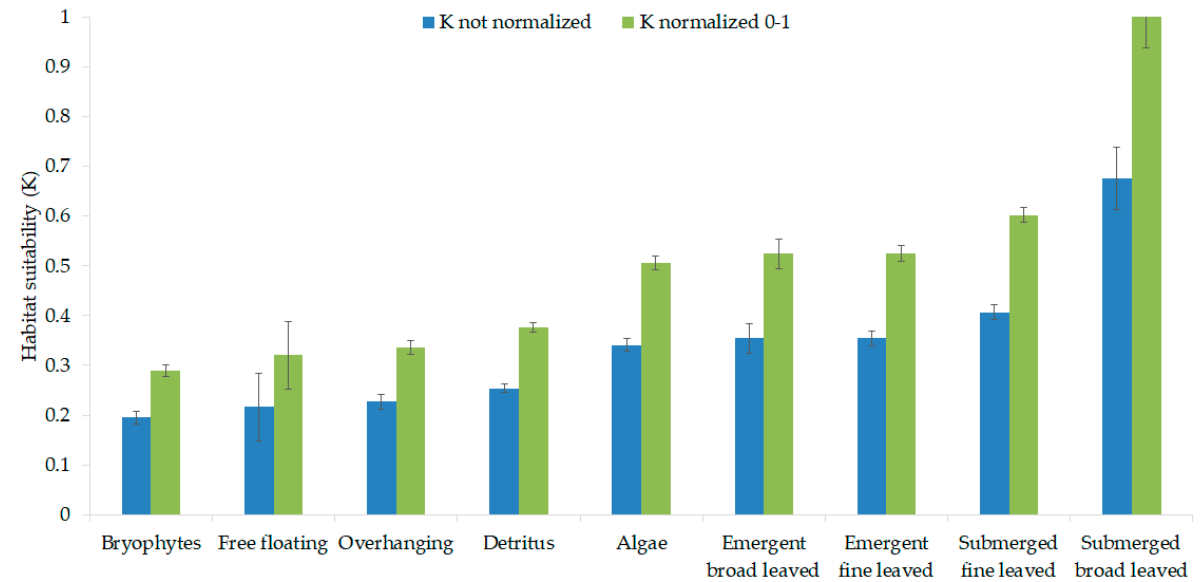
Figure 6. Average (±standard error) macroinvertebrate habitat suitability (K) of each vegetation type.